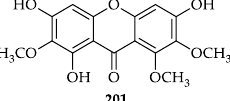
Table 4. Xanthones isolated in Eriocaulaceae species. Compounds MF [M − H] - Organ Species